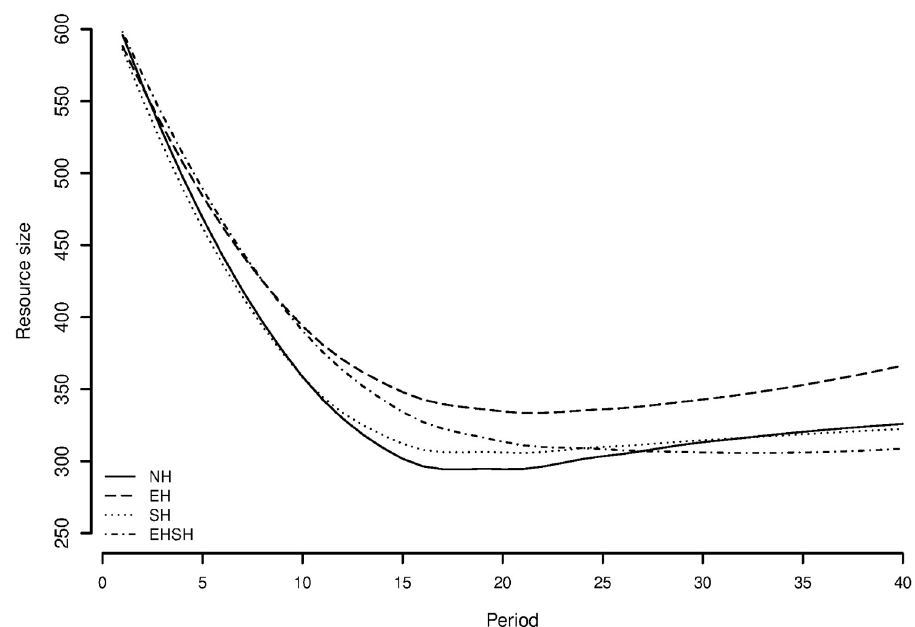
Fig 3. Mean resource size per treatment over